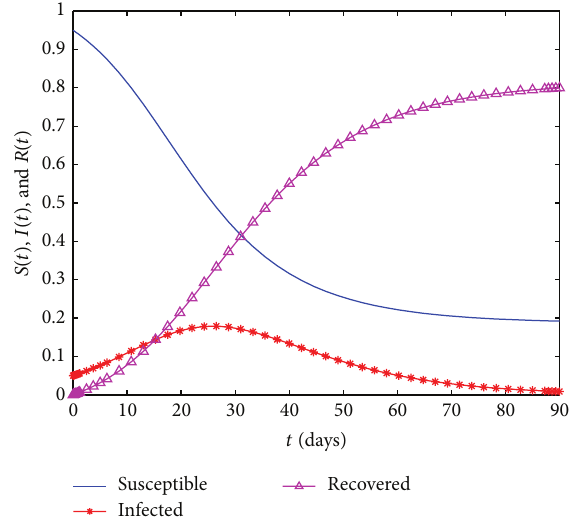
Figure 4: Solution to the 2014 outbreak Ebola model (5) with 𝛽 = 0.2 , 𝜇 = 0.1 , 𝑆(0) = 0.95 , 𝐼(0) = 0.05 , and 𝑅(0) = 0